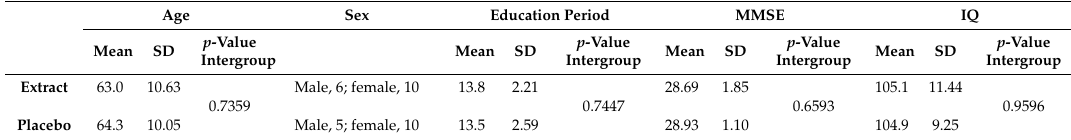
Table 1. Sociodemographic and baseline characteristics of the